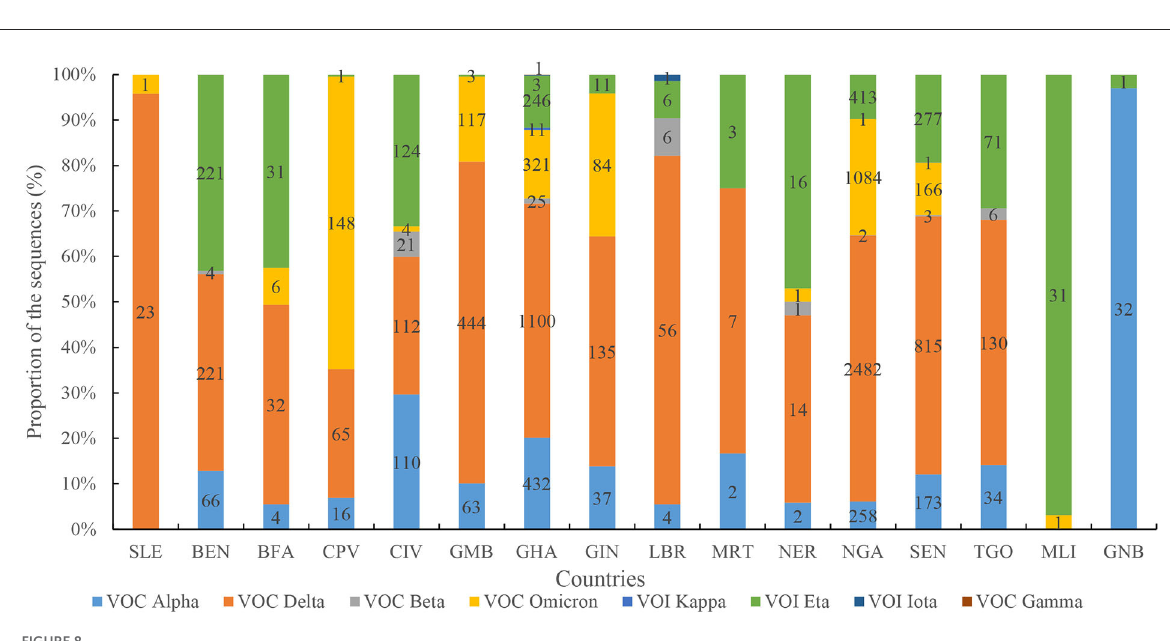
experiencing spikes in the number of COVID-19 cases and related deaths, which is now referred to as the third wave